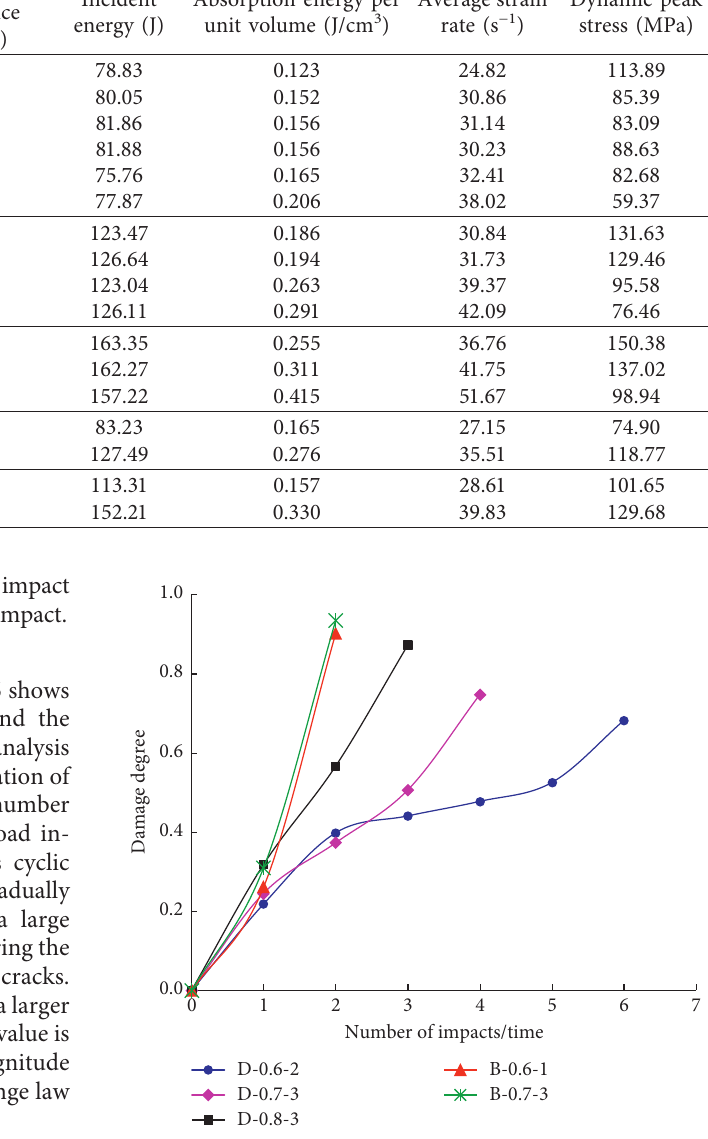
Figure 6: Relationship between the damage degree and number of